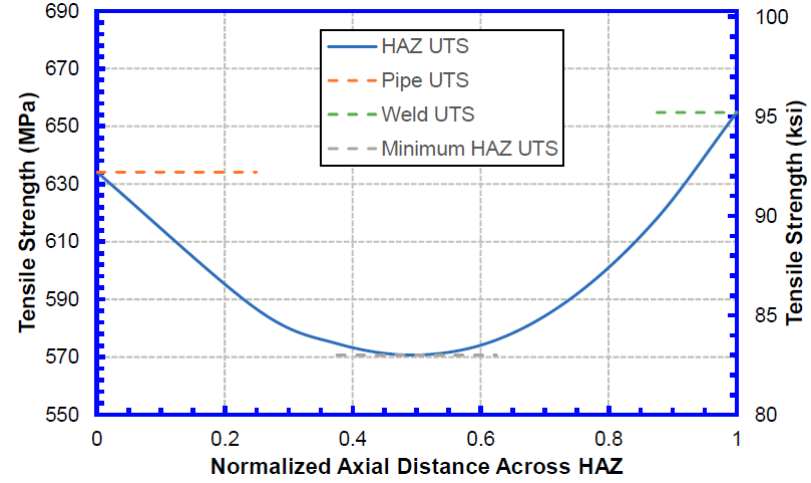
Figure 4. Profile of strength distribution in the HAZ.